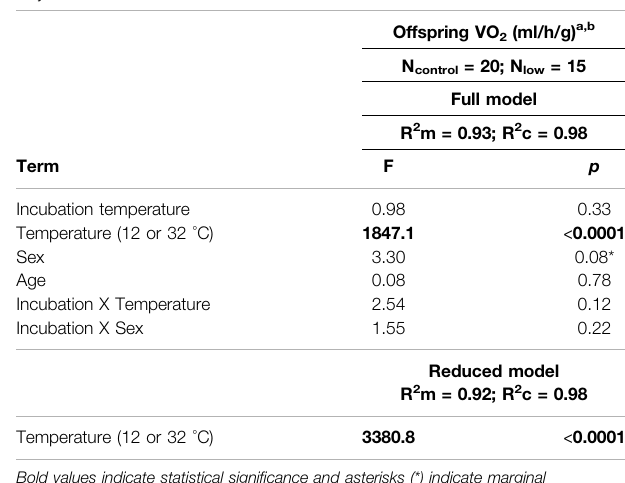
TABLE 3 | Full and reduced models investigating the effects of incubation temperature and temperature of measurement on offspring metabolism at Day 30.